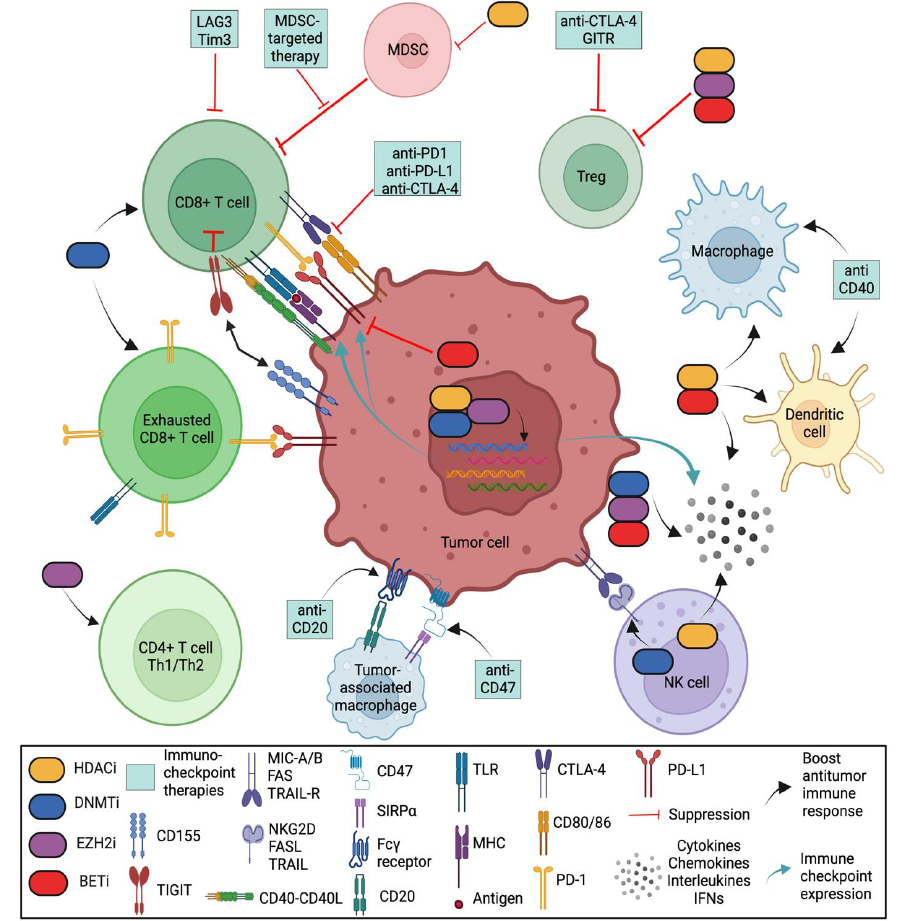
Figure 2. Role of various epigenetic modifiers in the tumor immune microenvironment. DNA methyltransferase inhibitors (DNMTis), histone deacetylase inhibitors (HDACis), an inhibitor of histone methylation on histone H3 at lysine 27 (EZH2i), and inhibitor of bromodomain and extra- terminal motif (BETi) shape the tumor-immune microenvironment by (i) increasing the number of CD8 and CD4 T cells; (ii) activating antigen processing and presentation machinery; (iii) decreasing the abundance of MDSCs and tumor-associated macrophages (TAMs); (iv) downregulating the immune checkpoint inhibitors Tim-3, Lag-3 and TIGIT; (v) upregulating immune checkpoint PD-L1 (by DNMTis, HDACis and EZH2i) and downregulating PD-L1 (by BETi); (vi) enhancing NK-mediated lysis (by HDACis) or decreasing NK cytotoxicity (by EZH2i); and (vii) upregulating inflammatory genes and pathways that control the secretion of interferons (IFNs), cytokines, and chemokines from tumor cells. (Regulatory T cells (Tregs) are a specialized subpopulation of T cells that act to suppress the immune response, thereby maintaining homeostasis and self-tolerance. It has been shown that Tregs are able to inhibit T-cell proliferation and cytokine production, as well as play a critical role in preventing autoimmunity. Tumor-associated macrophages (TAMs) are the key cells that create an immunosuppressive tumor microenvironment (TME) by producing cytokines, chemokines, and growth factors and by triggering the inhibitory immune checkpoint proteins release in T cells. Natural killer (NK) cells are effector lymphocytes of the innate immune system that control several types of tumors and microbial infections by limiting their spread and subsequent tissue damage. Cancer-associated fibroblasts (CAFs) are one of the most abundant and critical components of the tumor mesenchyme; they not only provide physical support for tumor cells but also play a key role in promoting and retarding tumorigenesis in a context-dependent manner. Recent studies have revealed their roles in immune evasion and poor responses to cancer